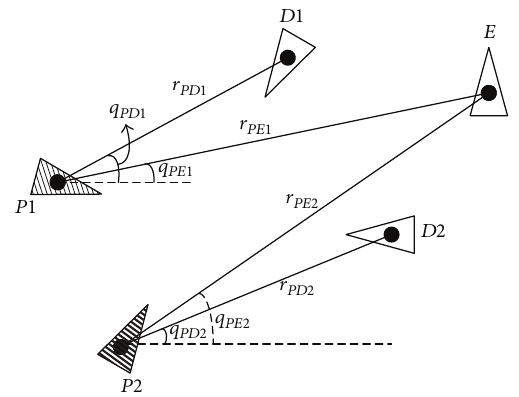
Figure 15: Two Defenders versus two Pursuers scenario.